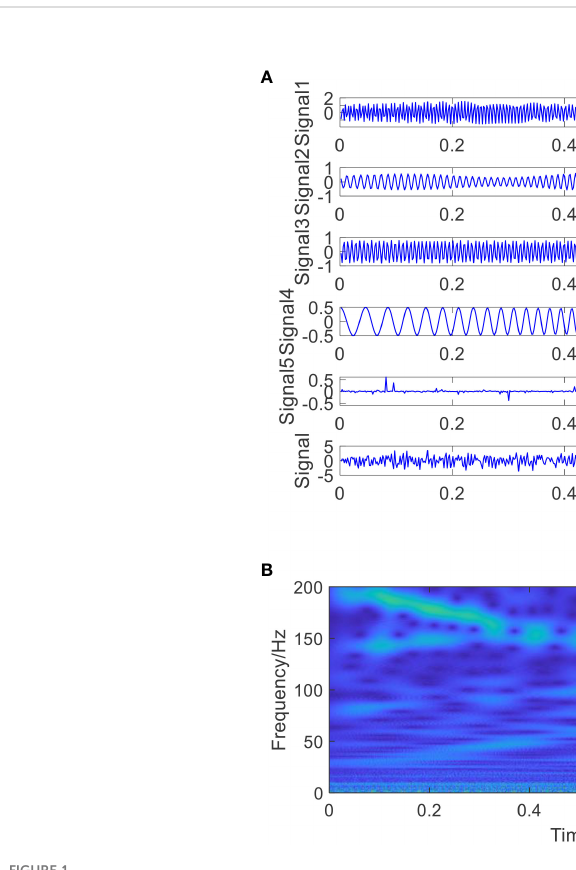
FIGURE 1 The simulated signal and its STFT diagram. (A) The simulated signal: from top to bottom are signal x 1 ( t ), x 2 ( t ), x 3 ( t ), x 4 ( t ), heavy tailed noise x 5 ( t ) and synthetic signal x ( t ); (B) the STFT diagram of the simulated synthetic signal.